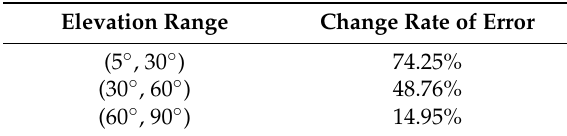
Table 3. Change rates of the non-nominal troposphere error for different elevation